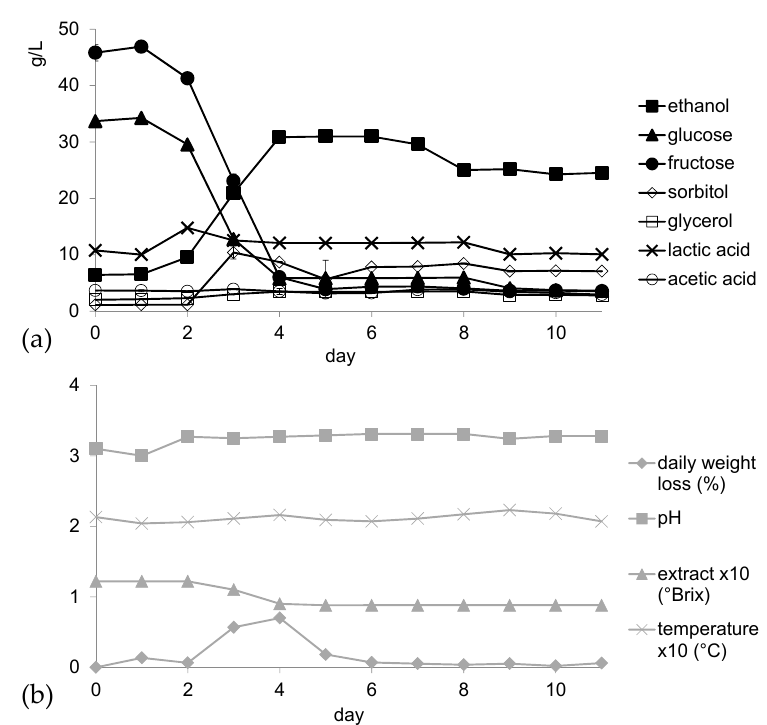
Figure 3. Fermentation analysis of chemical compounds ( a ) and process parameters ( b ).